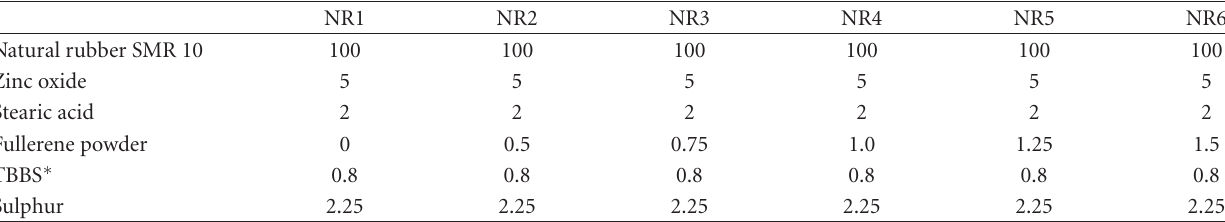
Figure 1: Micrographs of fullerene aggregates in transmission regime (a) and selected area of electron di ff raction regime (b). Table 1: Compositions of the NR-based rubber